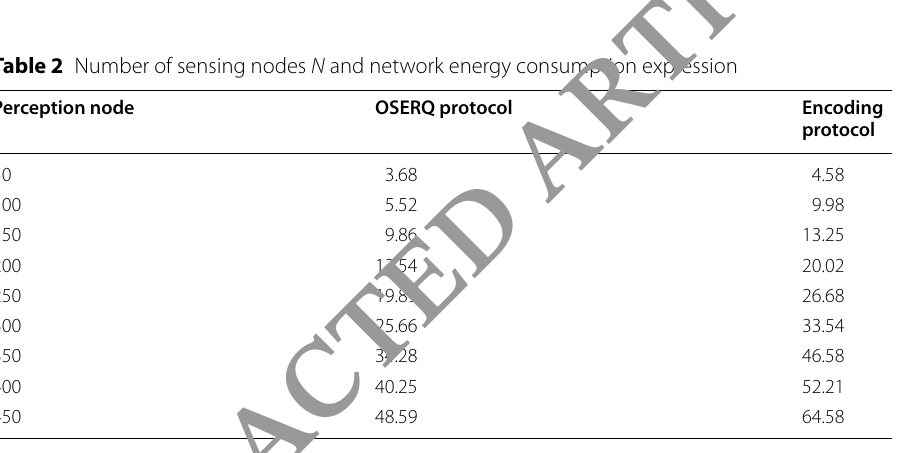
Fig. 8 Schematic diagram of wireless sensor network energy consumption